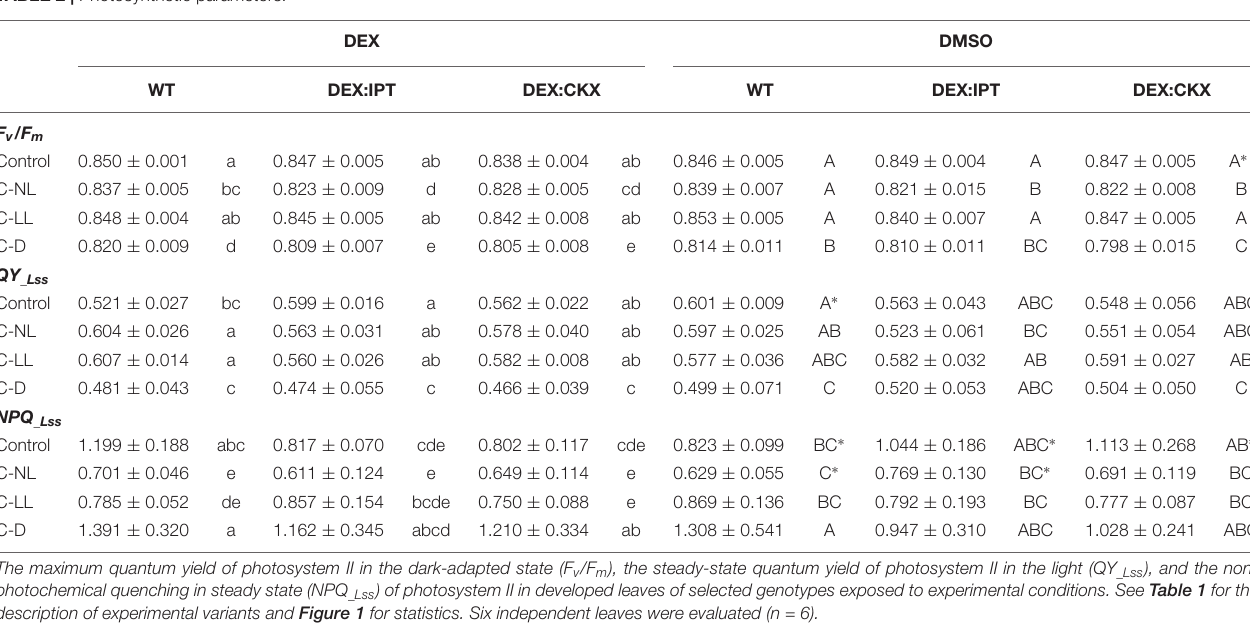
TABLE 2 | Photosynthetic parameters.